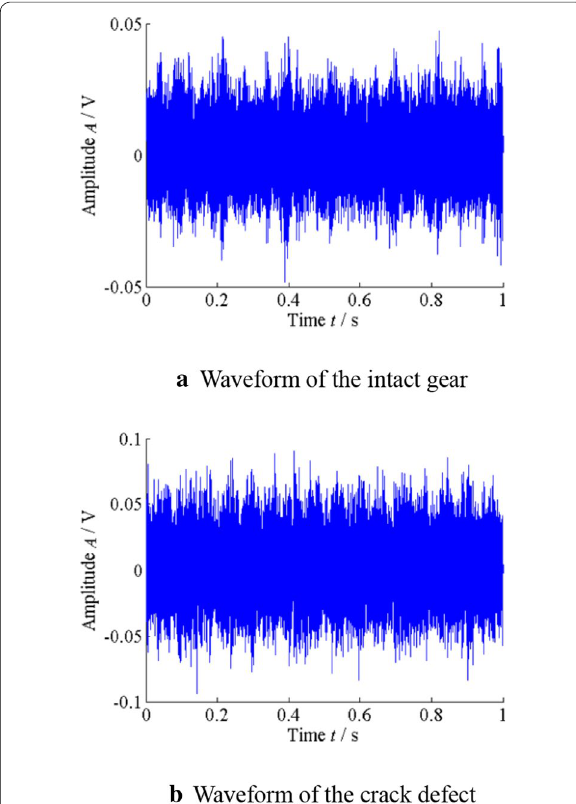
Figure 16 Waveform of the intact gear and the crack defect